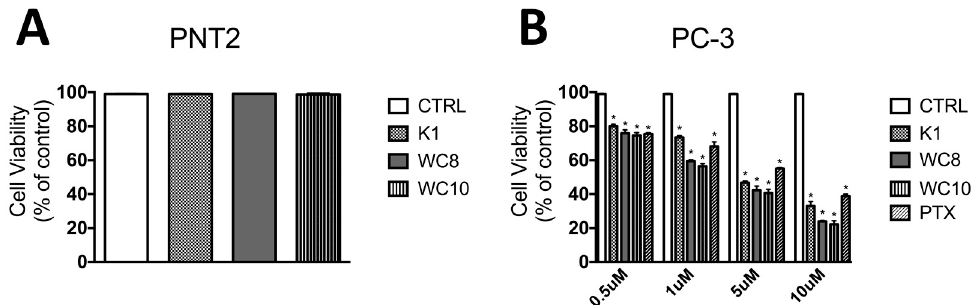
Figure 6. Effect of K1, WC8, and WC10 on cell viability. Cell viability was determined by MTS assay on PNT2 ( A ) and PC-3 cell lines ( B ) 96 h post-treatment. The absorbance was measured with a 96-well-plate spectrophotometer (Varioskan Flash Multimode Reader) at 490 nm.